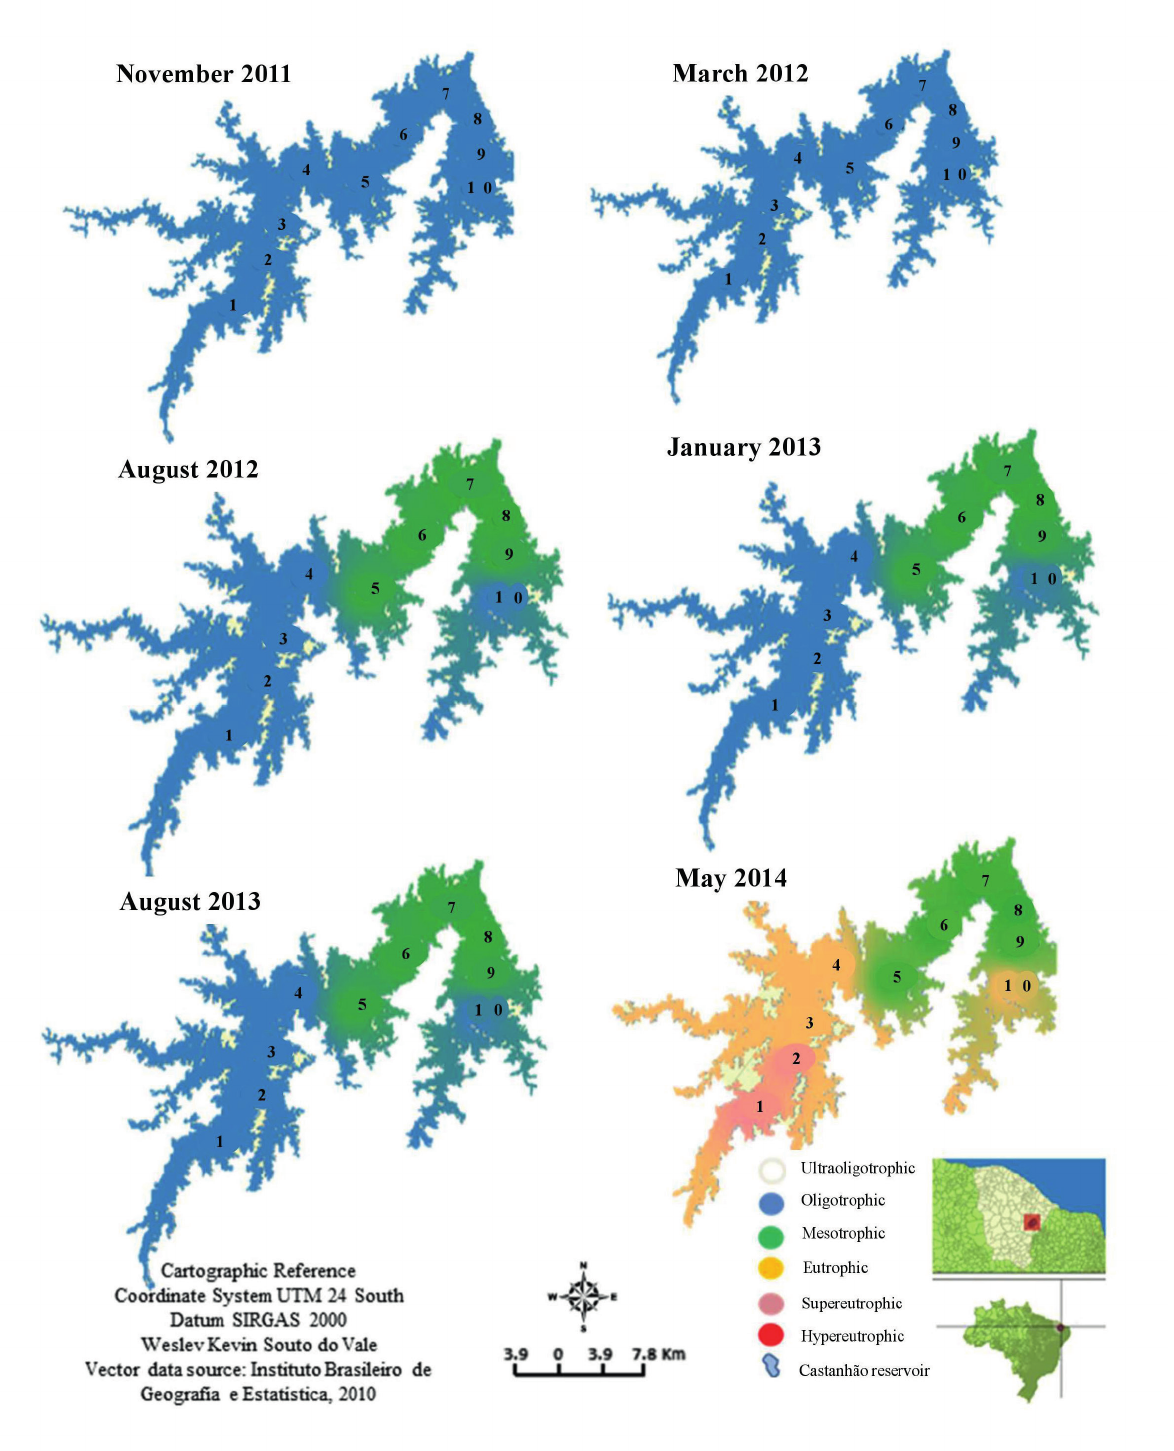
Figure 9 - Trophic state index changes in the Castanhão reservoir in NE Brazil, along the monitoring